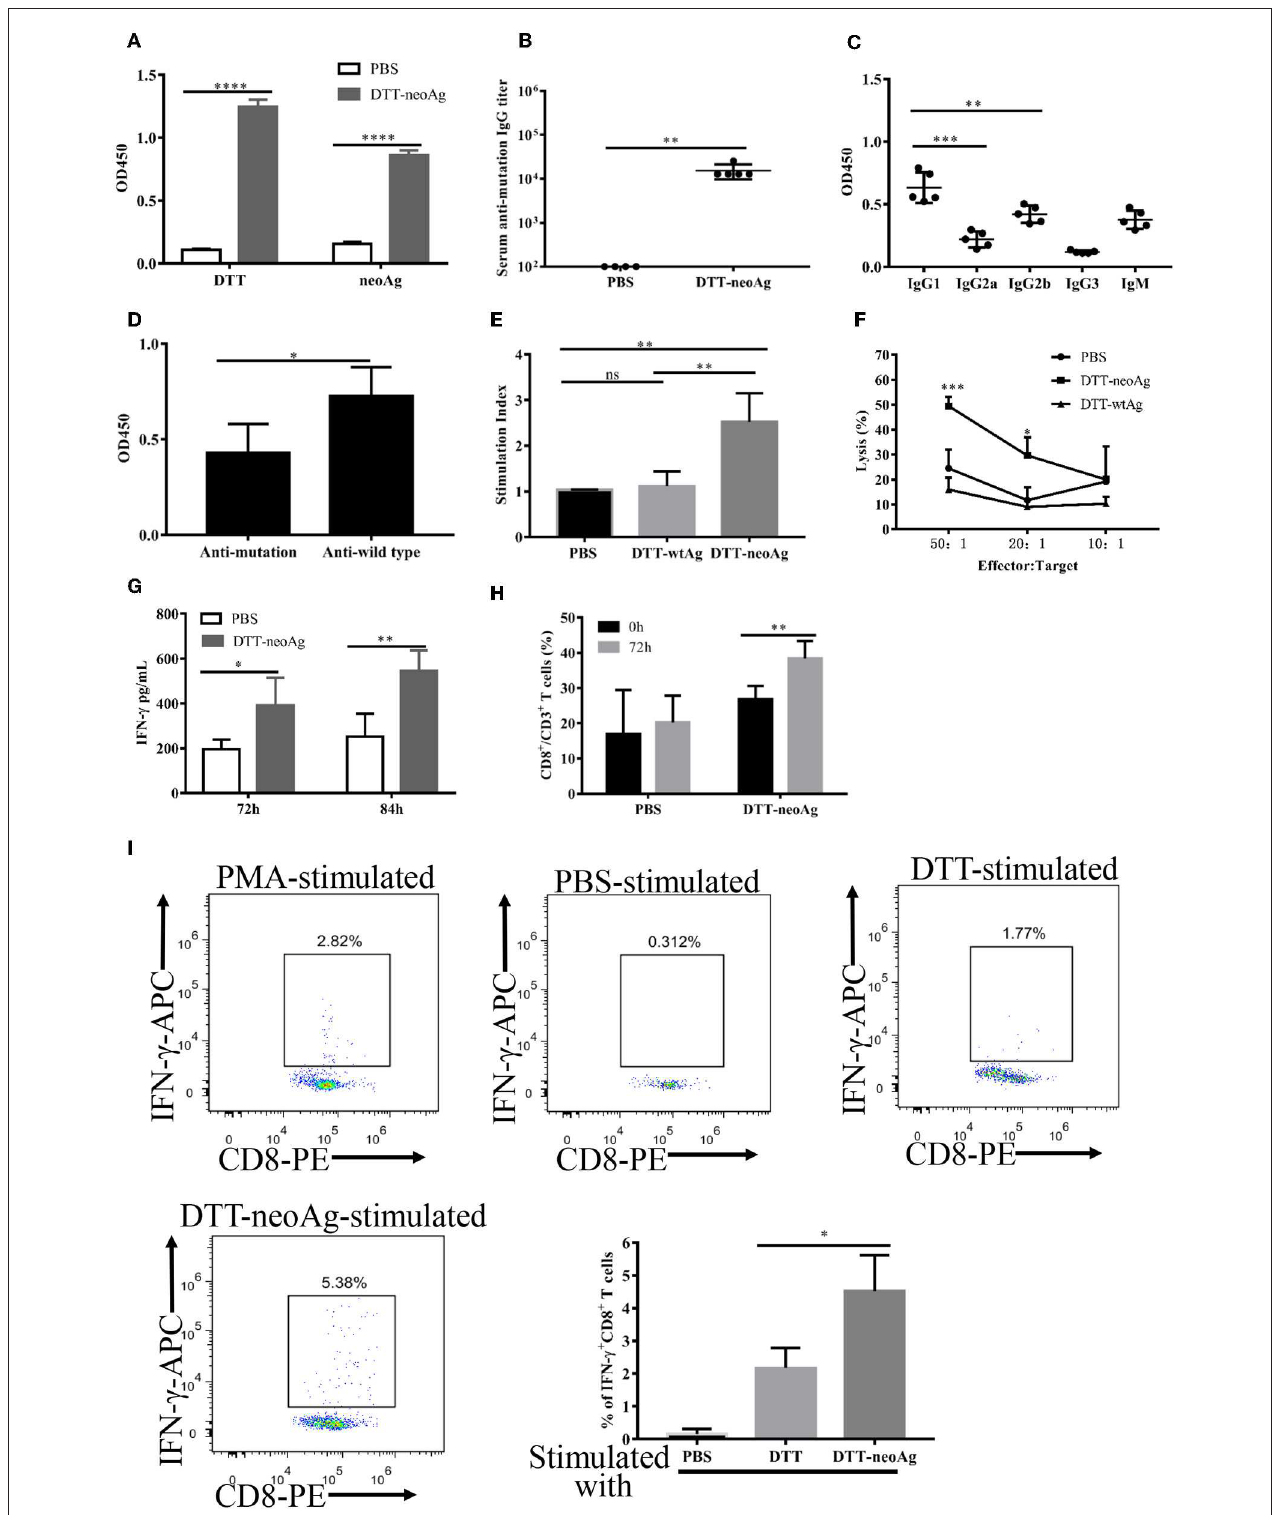
FIGURE 5 | Antibody responses and cellular immune responses elicited by DTT-neoAg vaccination in tumor challenged mice. The statistical significance was determined by Student’s T-test. *** P < 0.001; ** P < 0.01; * P < 0.05. (A–D) C57BL/6 mice ( n = 6–13) were administered s.c. with 2.5 × 10 4 B16 F10 cells into the right flank of the mice. Seven days after tumor challenge, mice were immunized three times at weekly intervals with DTT-neoAg, DTT-wtAg, or PBS, formulated with